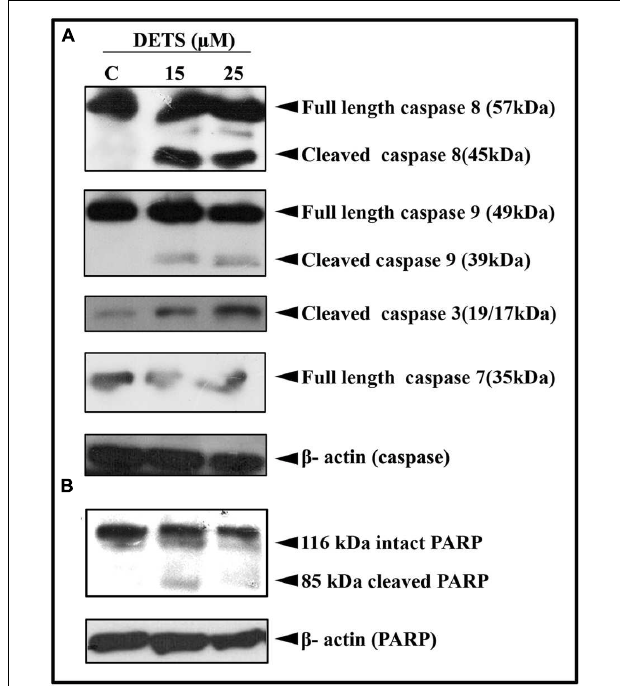
FIGURE 5 | DETS induces caspase-dependent apoptosis. (A) In A375 cells leading to PARP cleavage. (B) Whole-cell extracts were prepared after treating A375 cells with indicated concentration of DETS for 24 h and subjected to Western blotting using antibodies against the caspases, 8, 9, 7, and 3 and PARP. All results shown here are representative of three independent experiments with similar